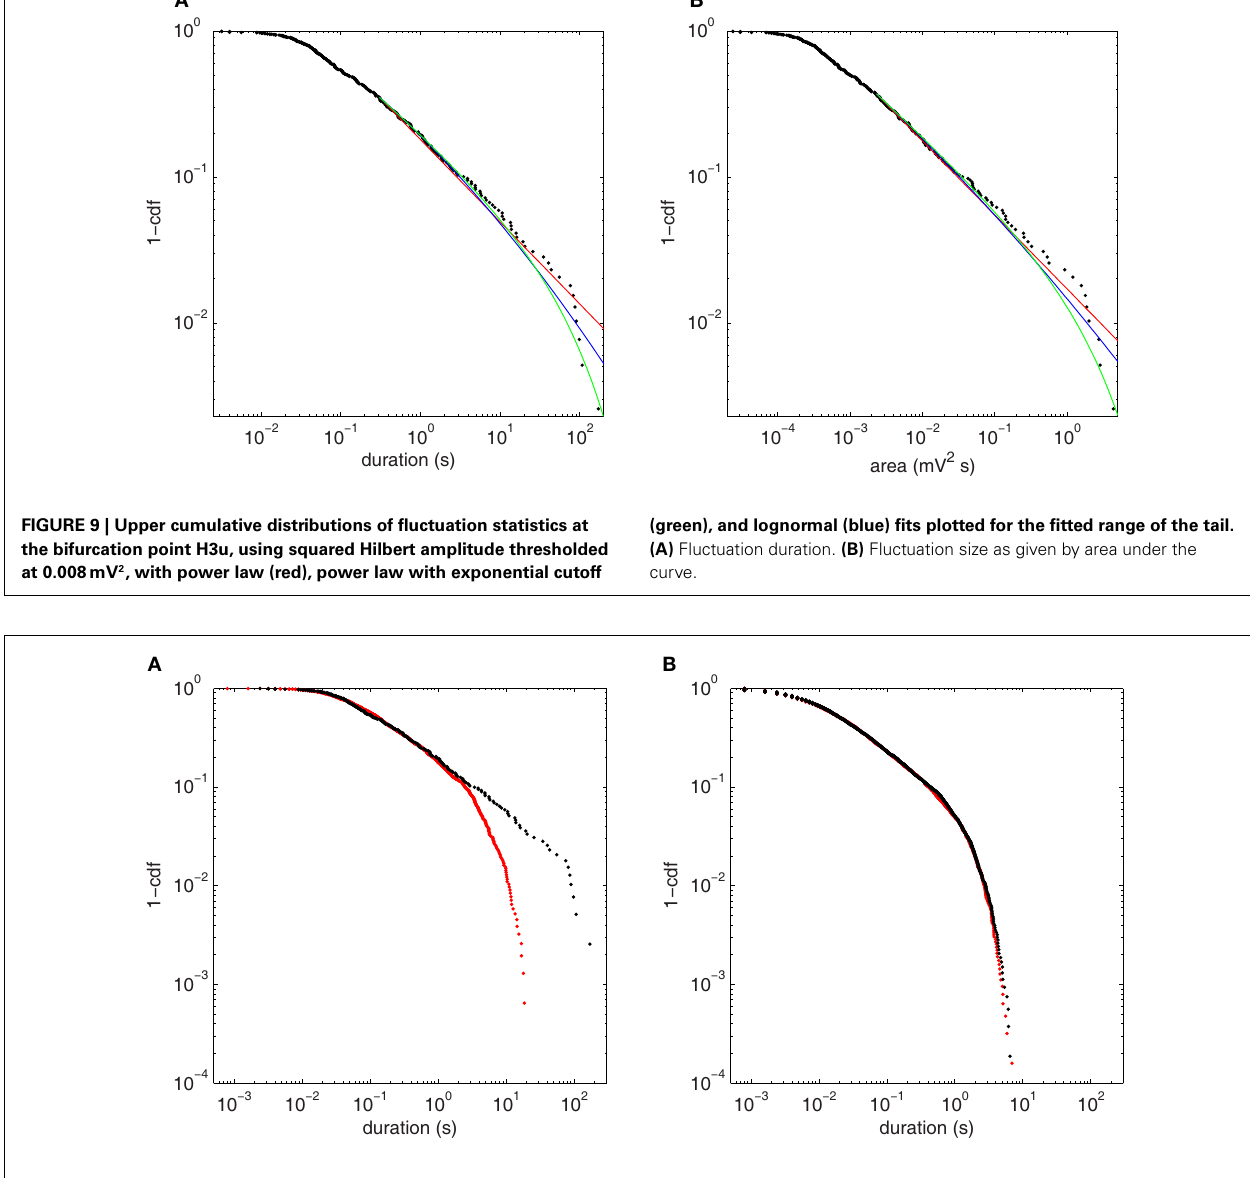
threshold = 0.008mV 2 ) and nearby more stable point (red, threshold = 0.0002mV 2 ). (B) Point H3p (black, threshold = 0.4mV 2 ) and nearby more stable point (red, threshold = 0.18mV 2